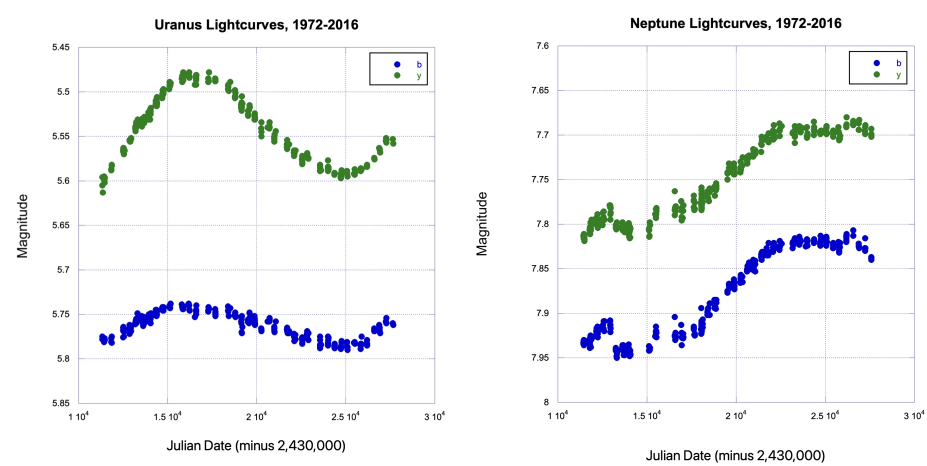
Figure 6. Disk integrated light curves of Uranus ( left ) and Neptune ( right ) in the Strömgren b (blue points) and y (green points) filters from 1972 to